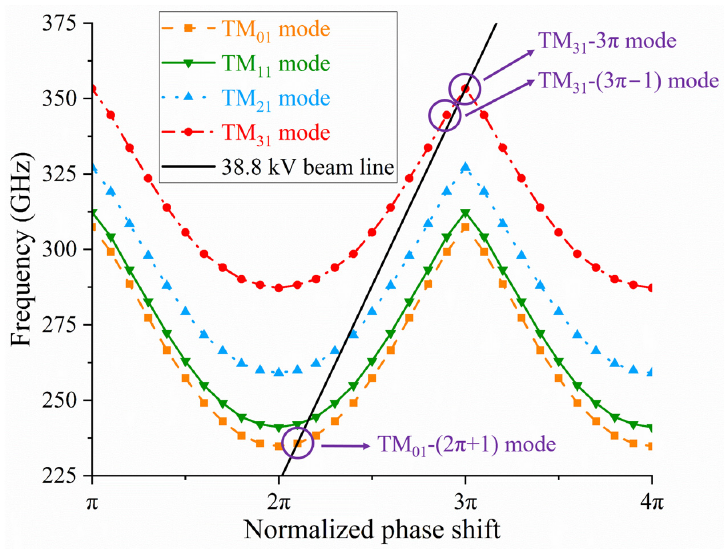
Figure 4. Dispersion relationships of the multiple sheet beam EIO circuits with different TM modes. In Figure 4, the orange, green, blue, and red curves represent TM 01 , TM 11 , TM 21 , and TM 31 modes, respectively. Each marker on the curves represents a mode. The intersections